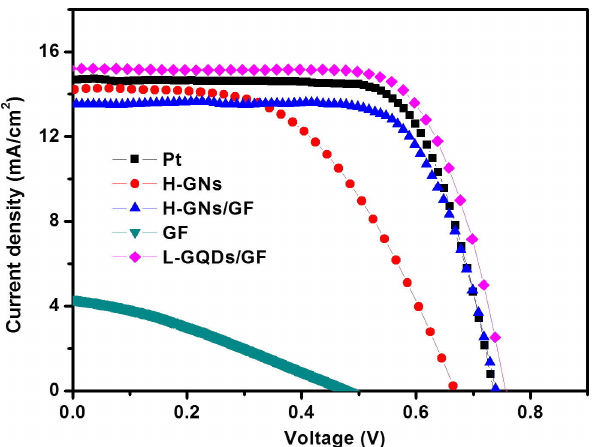
Figure 17. Photocurrent–voltage characteristics of DSSCs with various CEs (Pt, GF, H-GNs, H-GNs/GF, and L-GQDs/GF), measured under AM 1.5 simulated solar illumination. Reprinted from ref. [79], with permission from Elsevier.